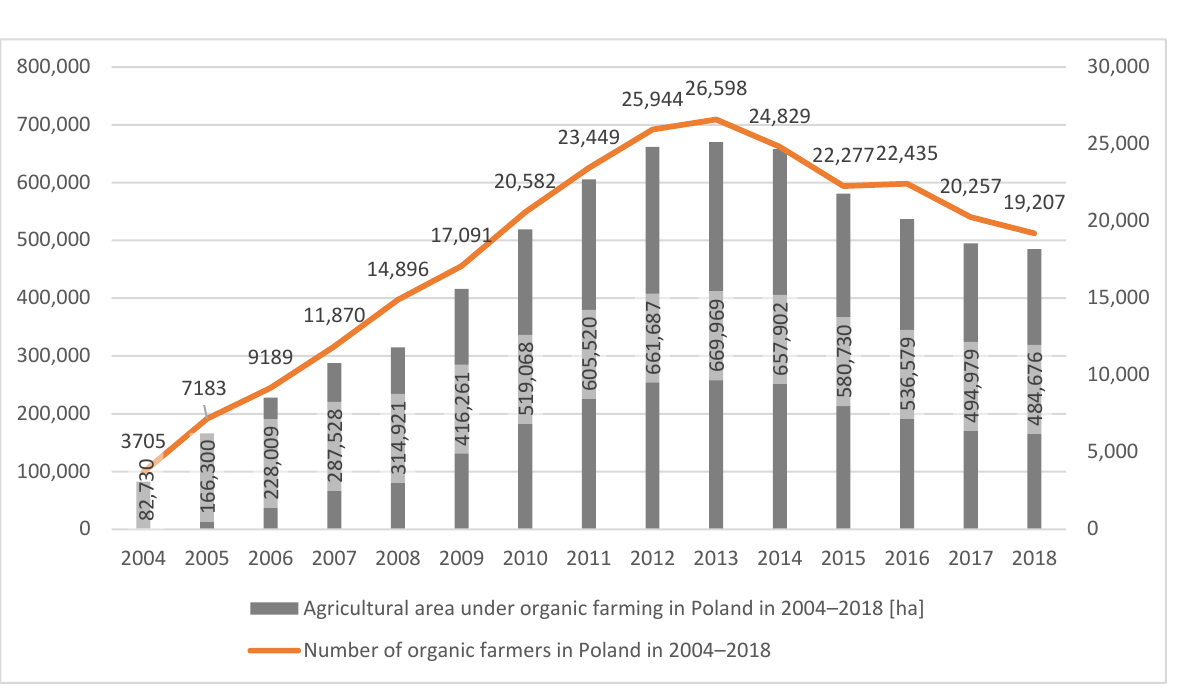
Figure 1. Organic agricultural land and the number of organic farms in Poland in 2004–2018. Source: own compilation based on [47].